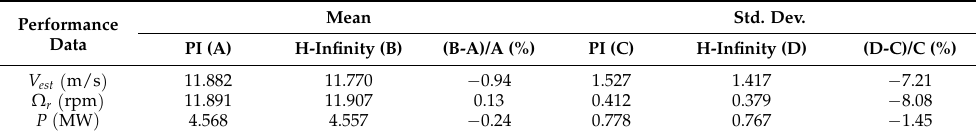
Table 3. Comparison of NTM results for performance data in 18 m/s noiseless environment.